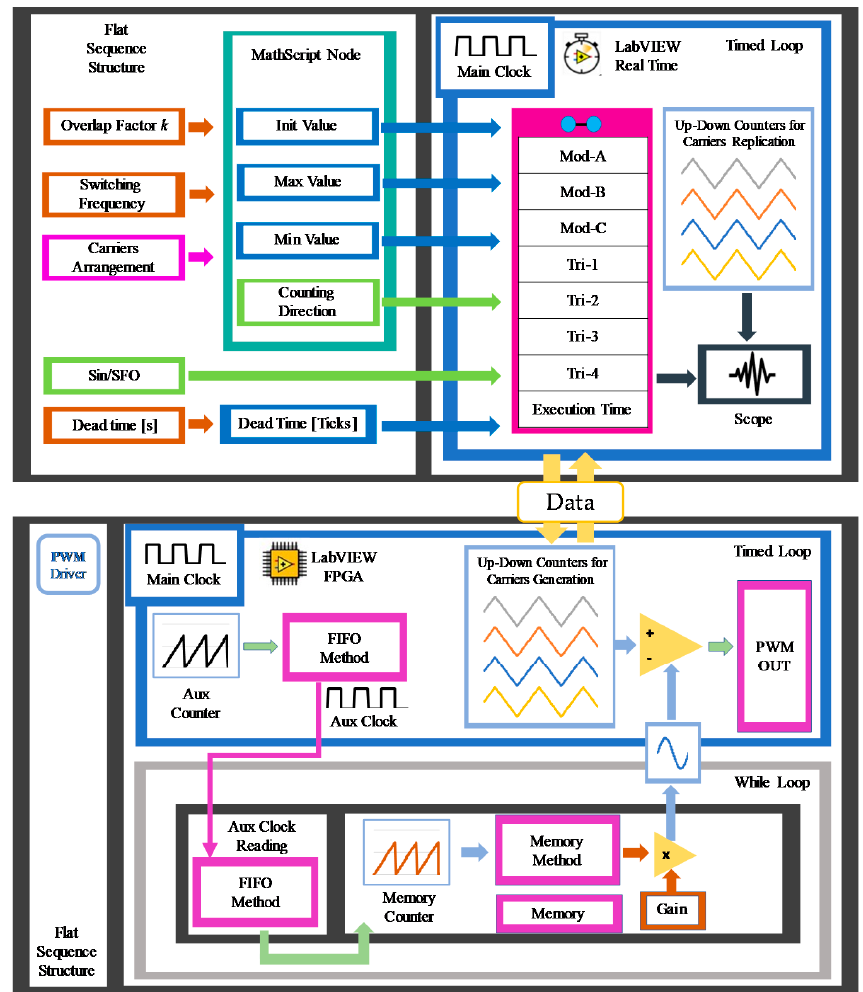
Figure 7. FPGA and real ‐ time block diagram synthesis.